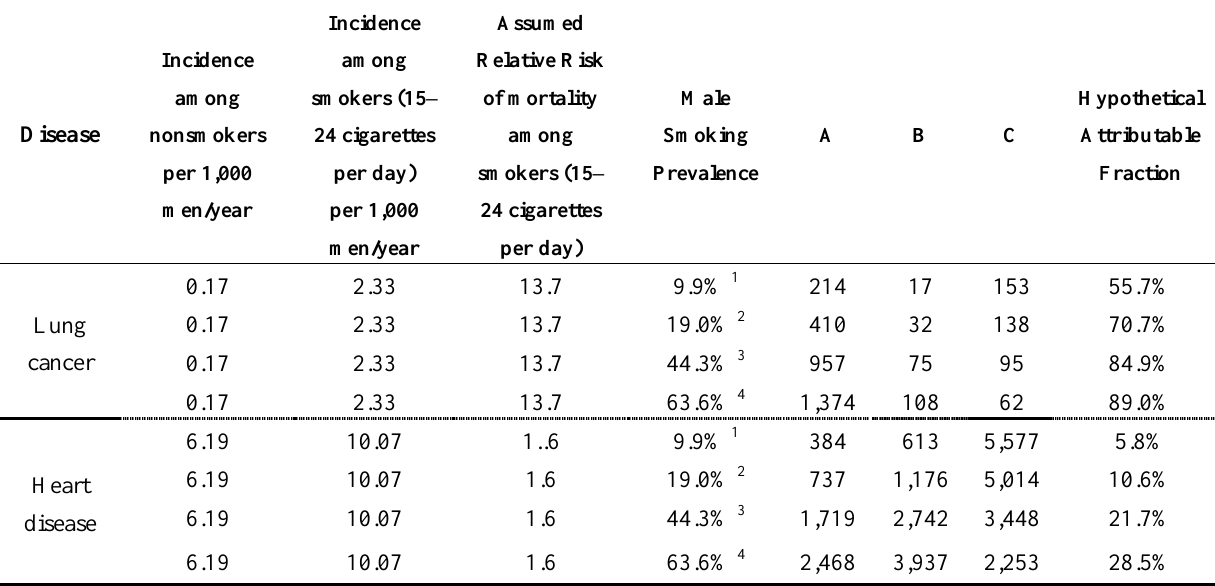
Table 1. Hypothetical burden of lung cancer and cardiovascular mortality due to smoking among